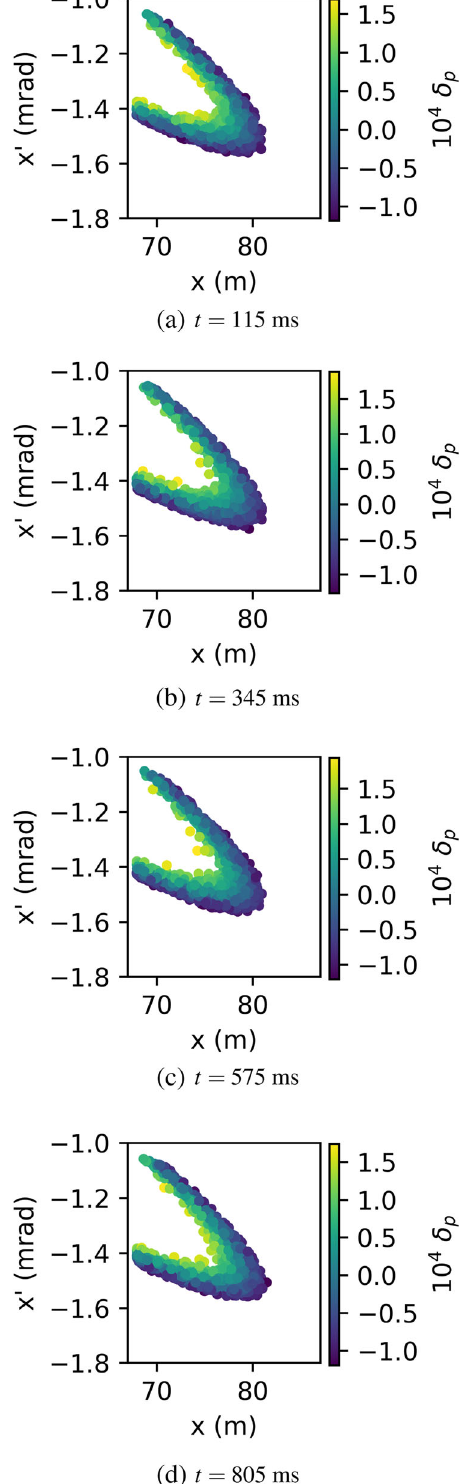
FIG. 4. COSE ( time independent ): instantaneous phase space presentation to the high-field side of the ZS in the presence of octupole fields simulated during a short spill on a 1.2 s